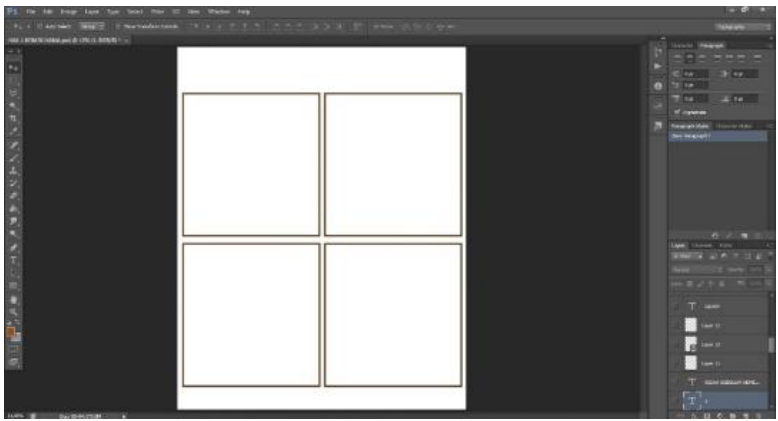
Figure 3. Canvas display and e-comic